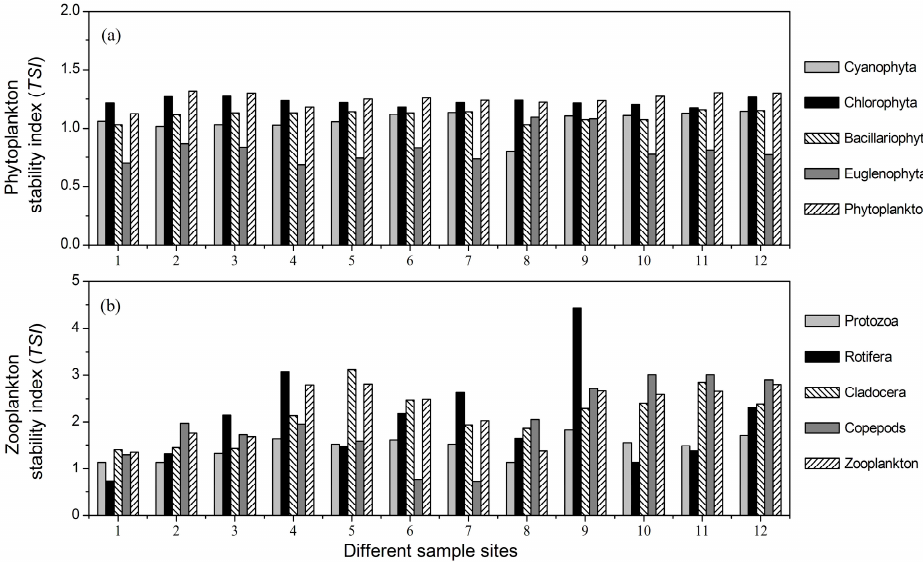
Figure 4. The stability indices of ( a ) phytoplankton and ( b ) zooplankton taxa at the 12 sample sites. TSI , temporal stability indices.